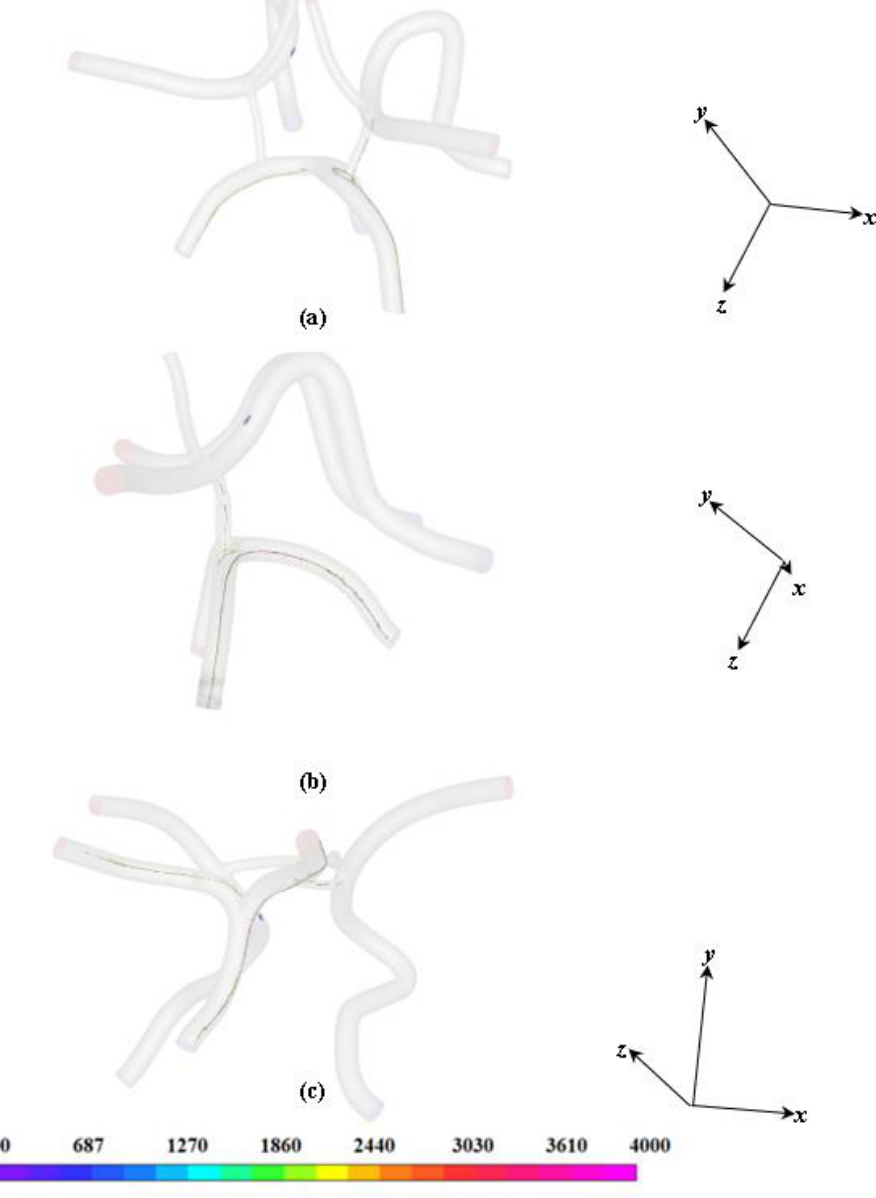
Figure 10. Heterogeneous particle distribution at different views: ( a ) isometric view, ( b ) side view, and ( c ) bottom view.